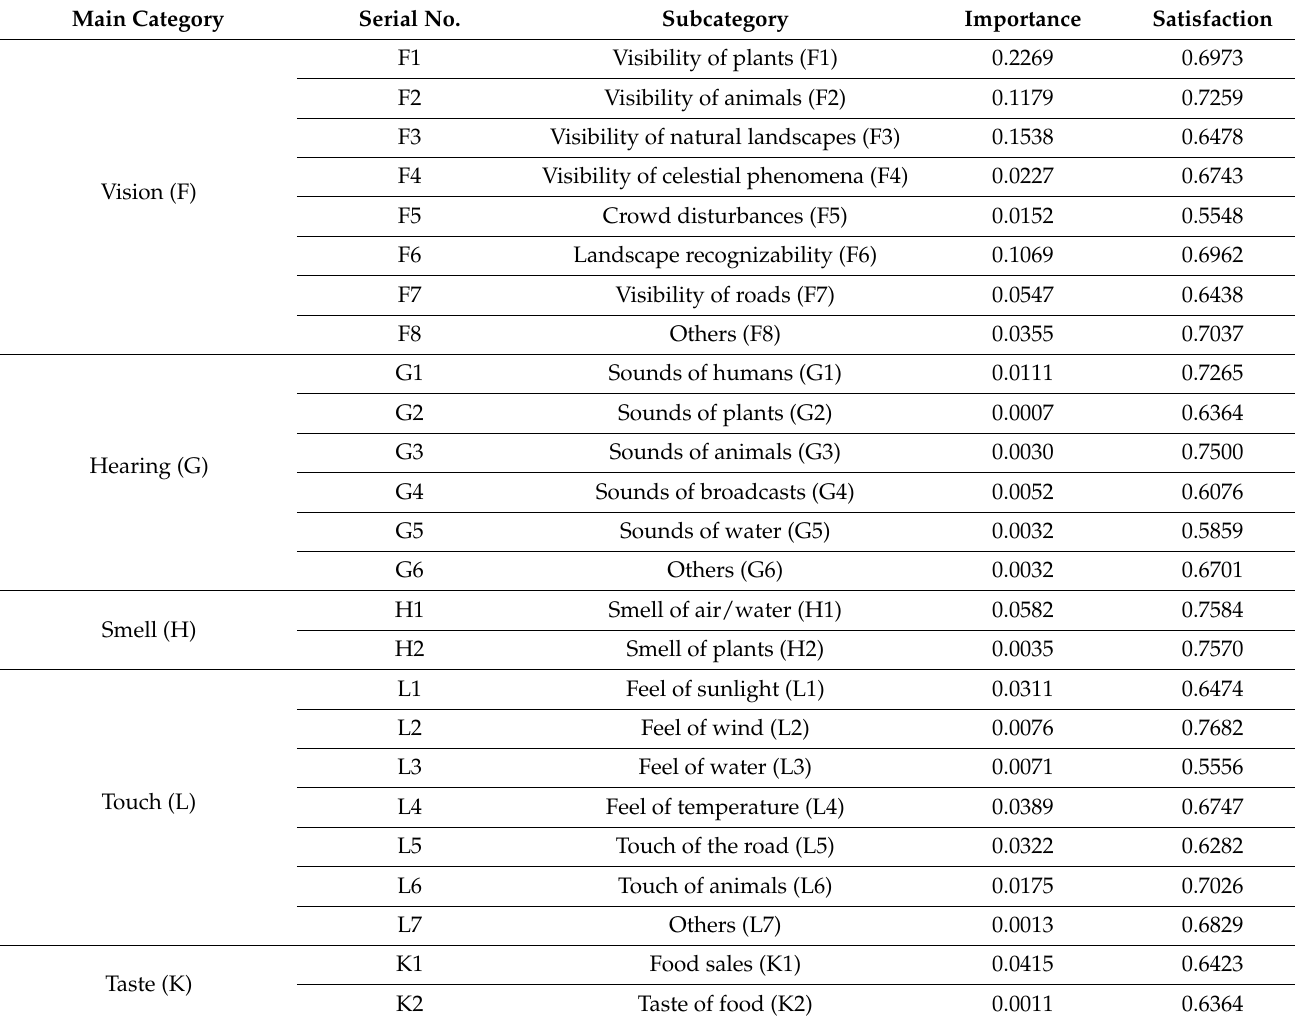
Table 11. Importance and satisfaction scores of the experience of the five